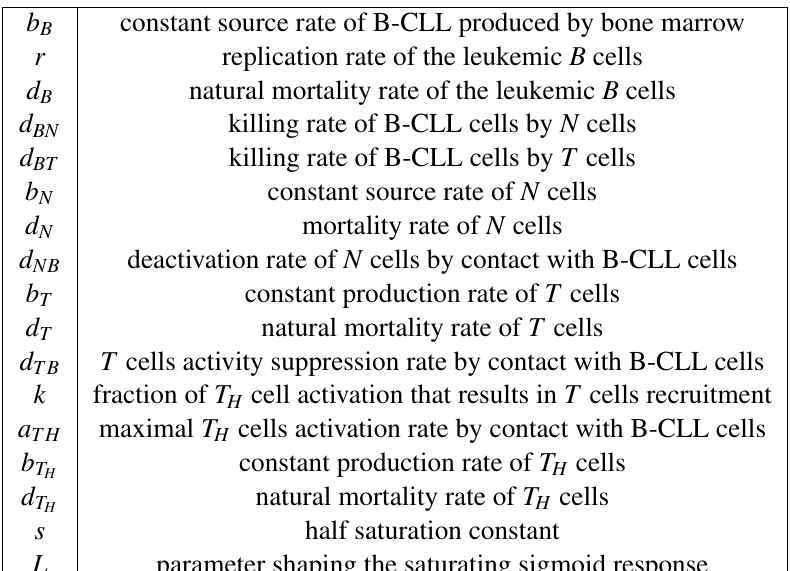
Table 1 Model parameters and their